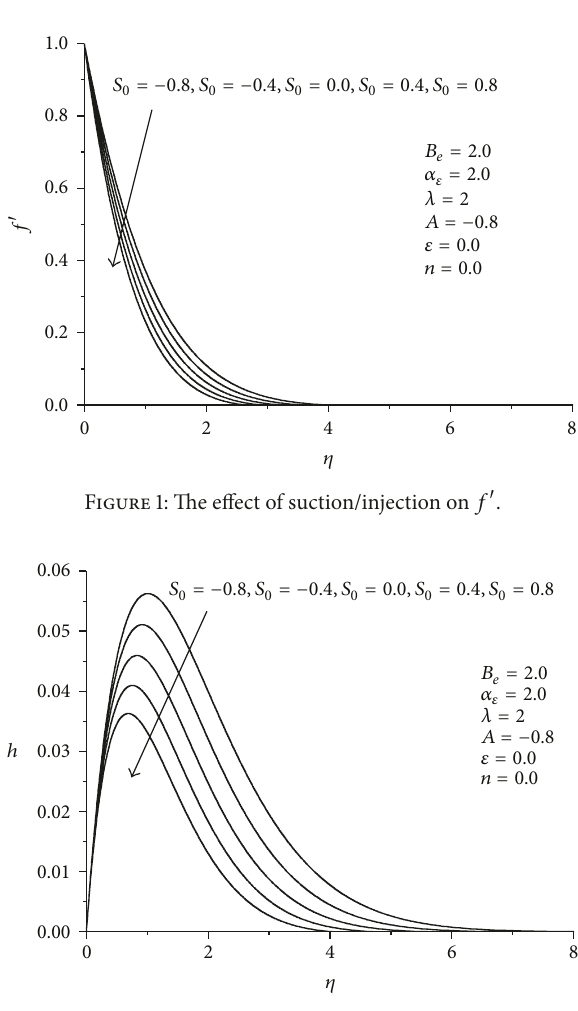
Figure 2: The effect of suction/injection on ℎ